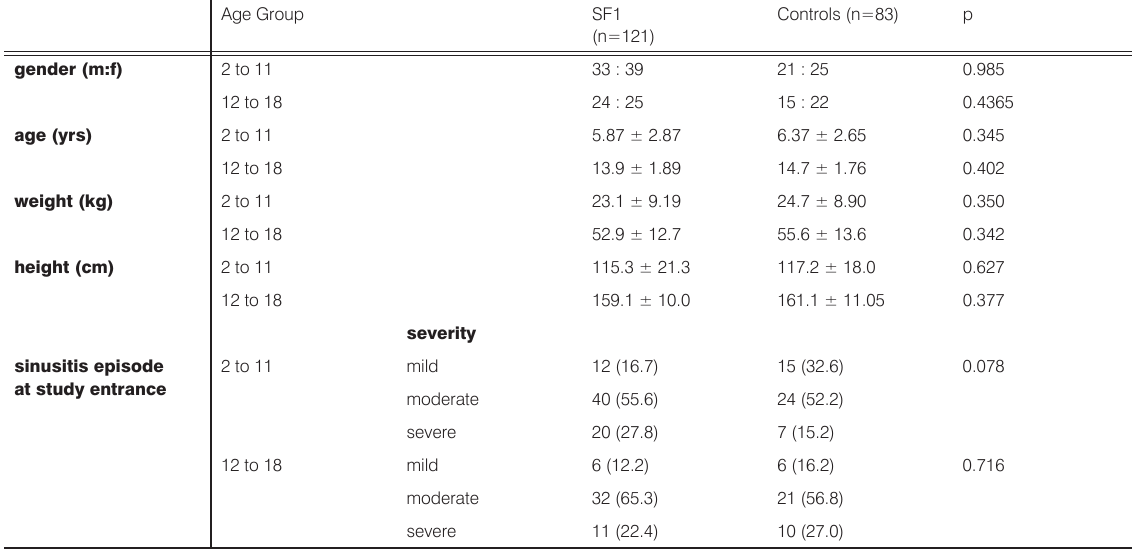
Table 1. Characteristics of the study population (mean ± SD)